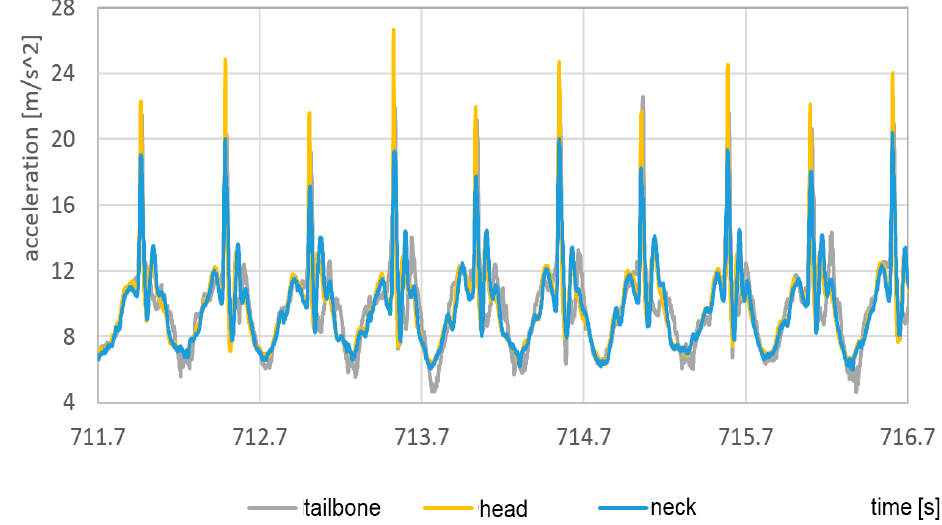
Figure 27. Vertical component of the head, neck, and tailbone during passage with bare feet.